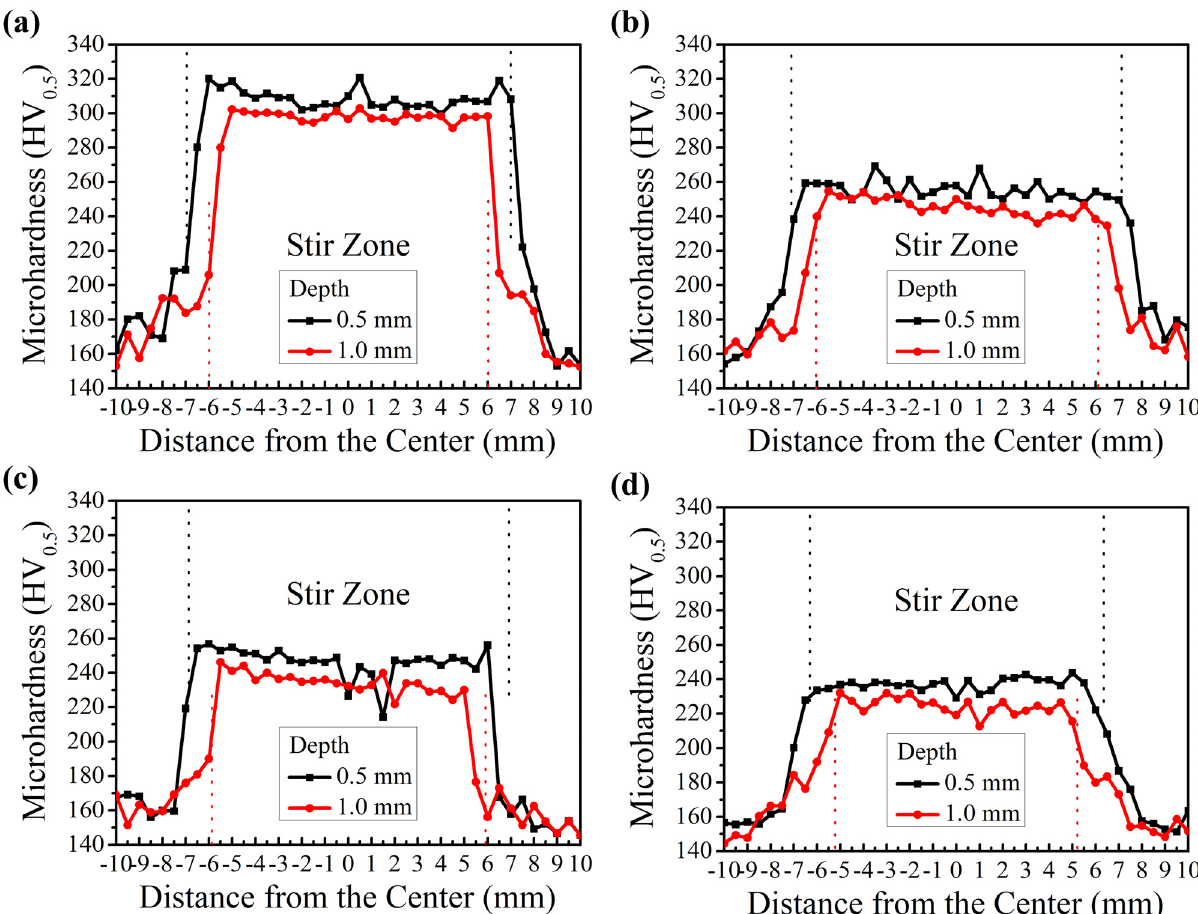
Figure 9: Microhardness distribution of the welds at ( a ) 200, ( b ) 300, ( c ) 400, and ( d ) 500 rpm. ( The dotted lines represent the border of SZ at two depths. )